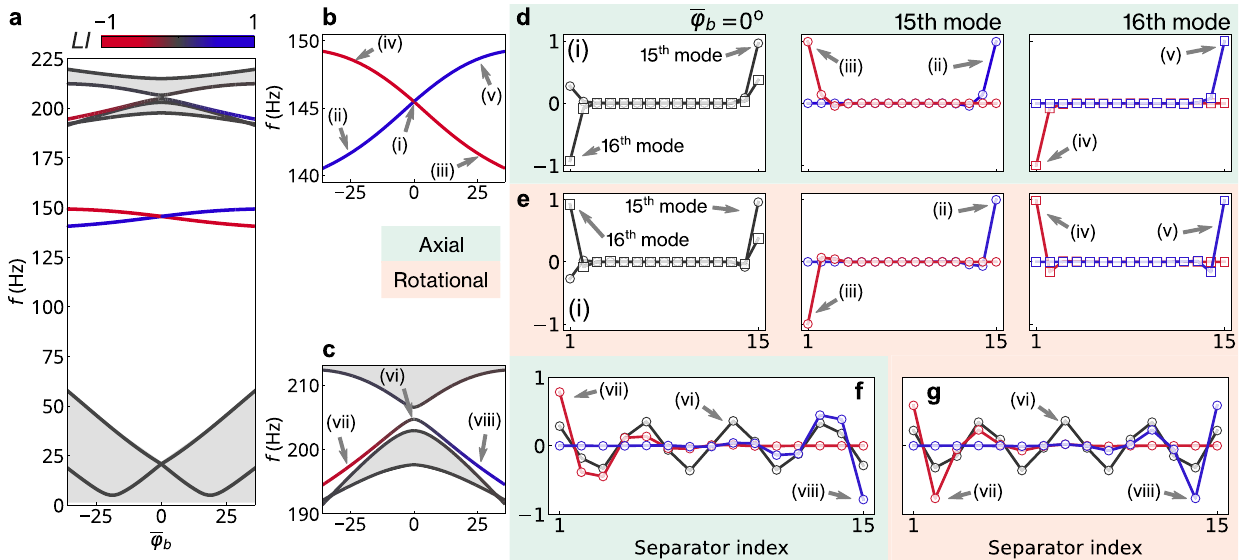
Fig. 3 Emergence of boundary states in the fi nite lattice with 16 unit cells under fi xed- fi xed boundary conditions. a The cut-off frequencies of the four branches in the coupled system, and the boundary state frequencies as a function of twist angle. From lowest to highest: upper cut-off frequencies of the fi rst and second branch; boundary state mode in BG1 (15th and 16th mode); lower and upper cut-off frequencies of the third branch, boundary state mode in BG2 (23rd mode); lower and upper cut-off frequencies of the fourth branch. The color intensity of the solid lines represents the localization index LI de fi ned in Eq. (8). b , c show the enlarged view of the boundary state frequencies in BG1 and BG2: b 15th and 16th modes; c 23rd mode. The areas shaded with the light-gray correspond to the bulk mode frequency regimes. d , e The 15th and 16th boundary modes in BG1 in axial (green background panel) and ¼ 0, (ii) − 25°, (iii) 25°. For the 16th mode, (i) φ ¼ 0, (iv) − 25°, (v) 25°. f , g The 23rd boundary rotational (red) components. For the 15th mode, (i) φ b b ¼ 0, (vii) − 25°, (viii) mode in BG2 in axial and rotational components. (vi) φ b Figure 3a summarizes the transition of the cutoff frequencies and boundary state frequencies of the fi nite lattice with 16 unit 2 ½(cid:2) 30 (cid:3) ; 30 (cid:3) (cid:4) . The color cells, as a function of twist angle φ b intensity of the lines corresponds to the localization index (LI) inspired by the inverse participation ratio (IPR) 49 and the center of mode (CoM) 29 :